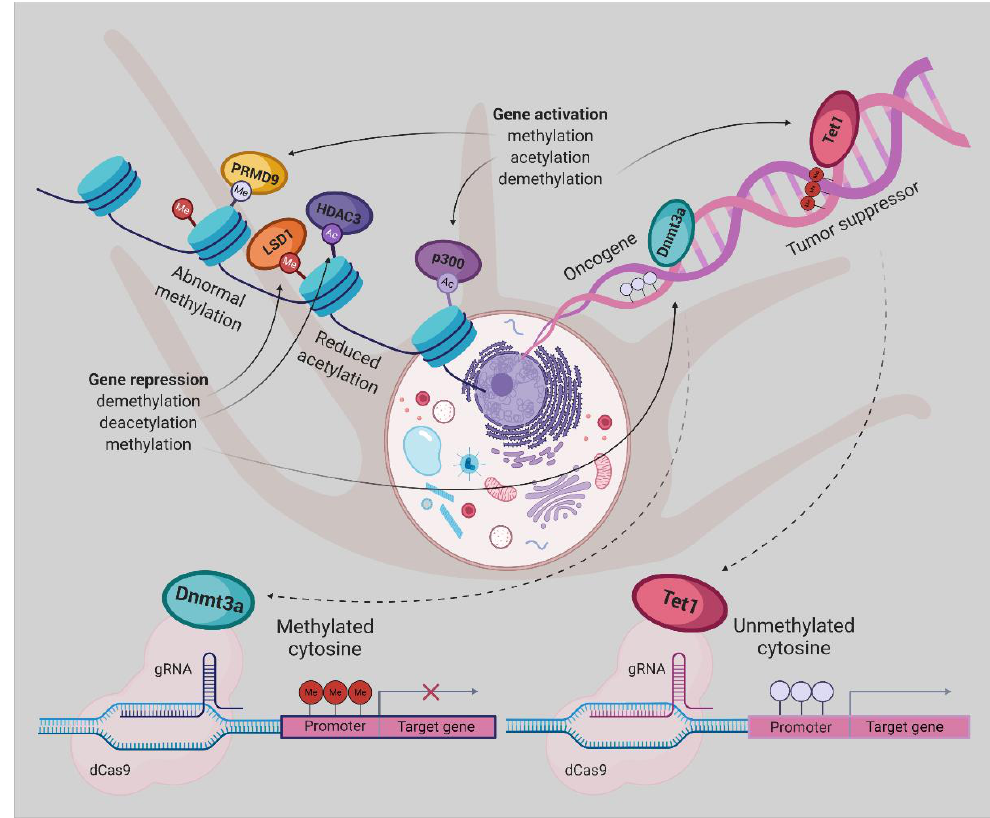
Figure 2. Epigenetic editing by CRISPR / dCas9, allowing for locus-specific control of epigenetically regulated gene expression, provides a more specific alternative to epigenetic drugs. DNA methylation or histone modifications can be restored using dCas9 protein fused or non-covalently bound to epigenetic e ff ectors, derived from writers or erasers. Gene expression has been activated by DNA demethylation using Tet1, H3K27 acetylation by p300, or H3K4 trimethylation by PRDM9. The antagonistic e ff ect can be achieved either by promoter methylation employing Dnmt3a, removal of a methyl group from H3K4me1 / 2 and H3K9me2 by LSD1 or deacetylation of H3K27ac by HDAC3